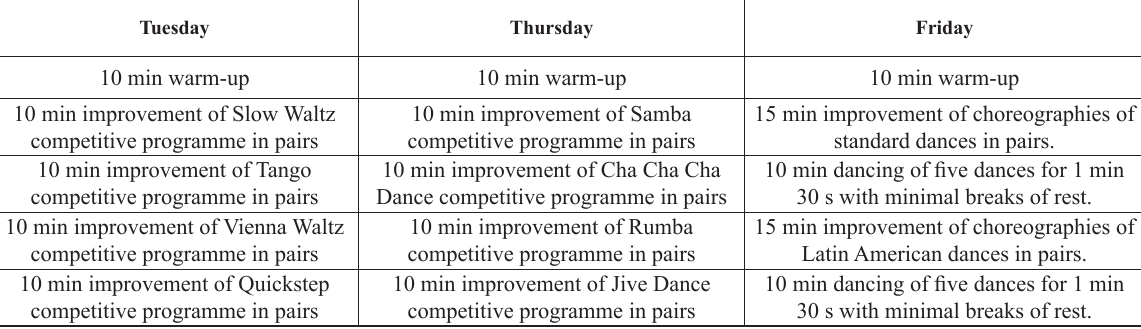
Table 3. The model of a weekly micro-cycle of pre-competition practice